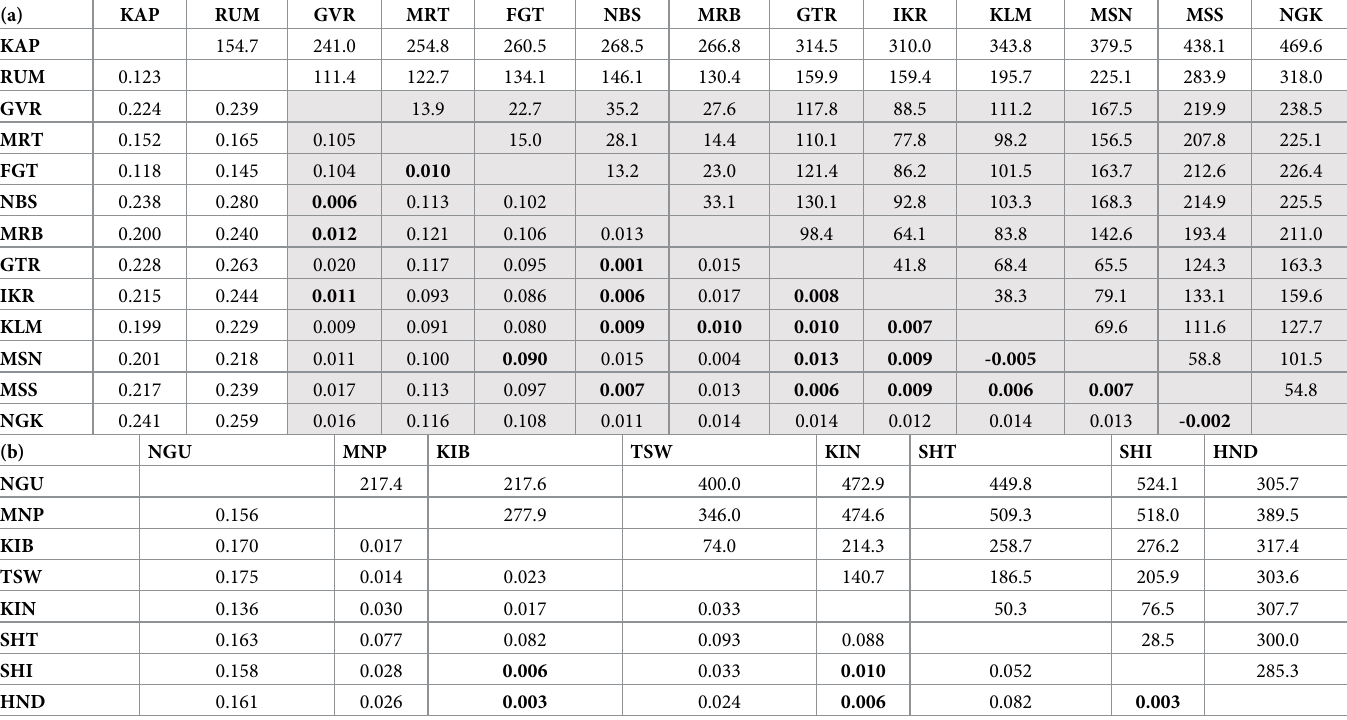
Table 3. Pairwise genetic and geographic